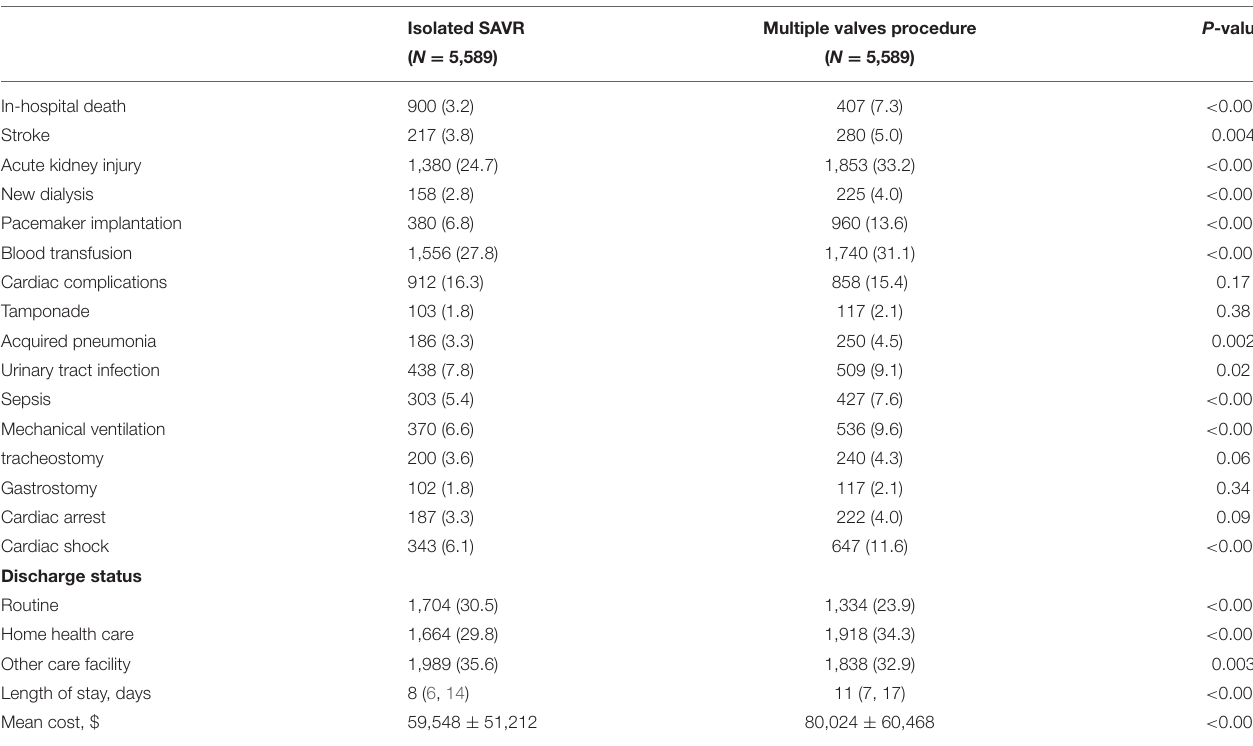
TABLE 4 | In-hospital Outcomes for isolated SAVR and SAVR with Multiple valves procedure in the Propensity Matched